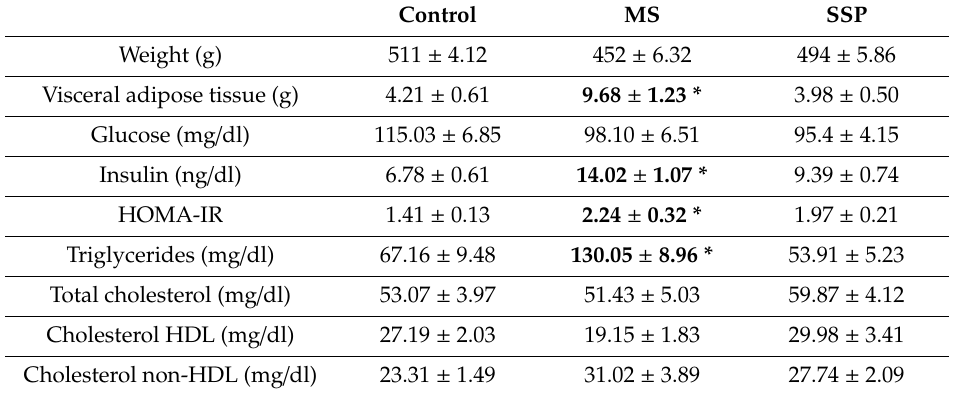
Table 1. Biochemical variables in control, long-term glucose exposure (MS; from postnatal day 12 to 7 months of age), and short-term glucose exposure (SSP; from postnatal day 12 to 28) specimens.